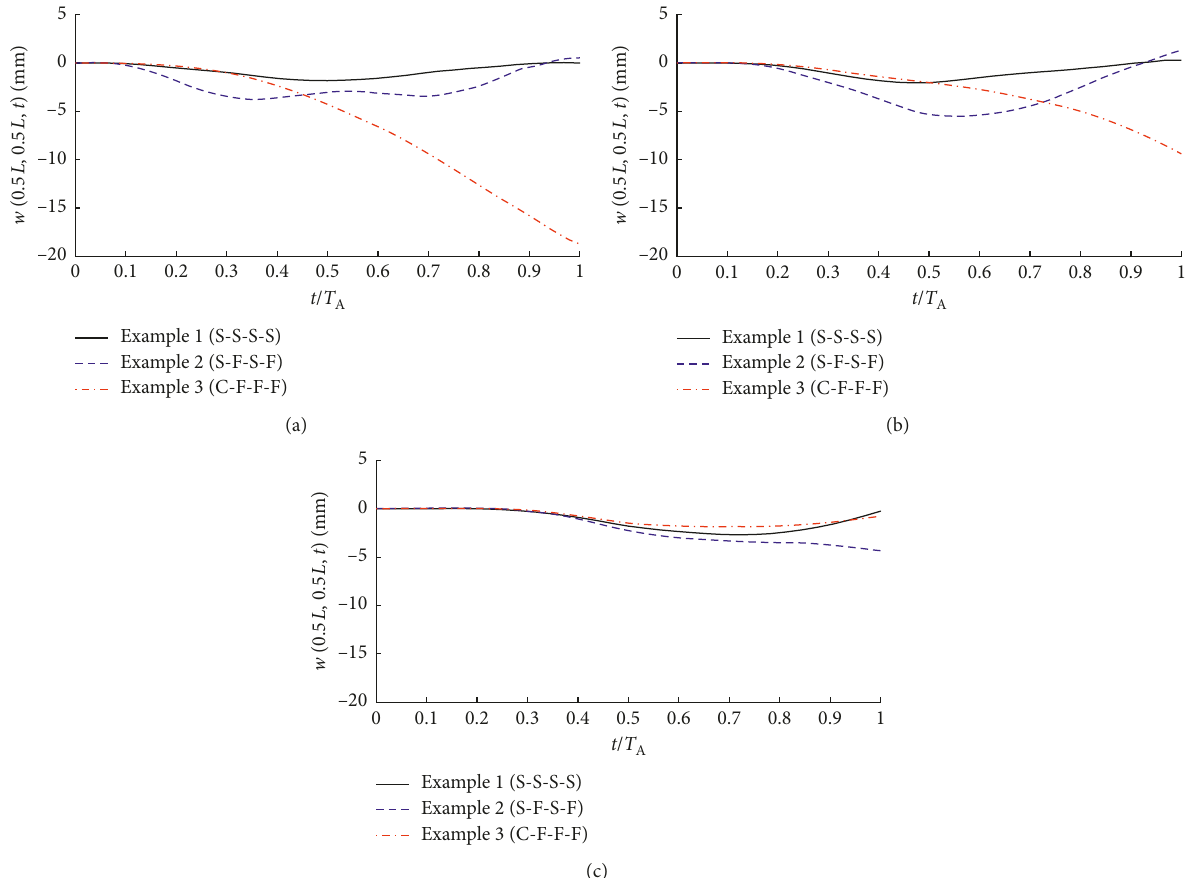
0 on the vibration responses at the center of three square plates when 1m/s, (b) v 0 2 m/s, and (c) v 0 (cid:31) (cid:31) (cid:31)